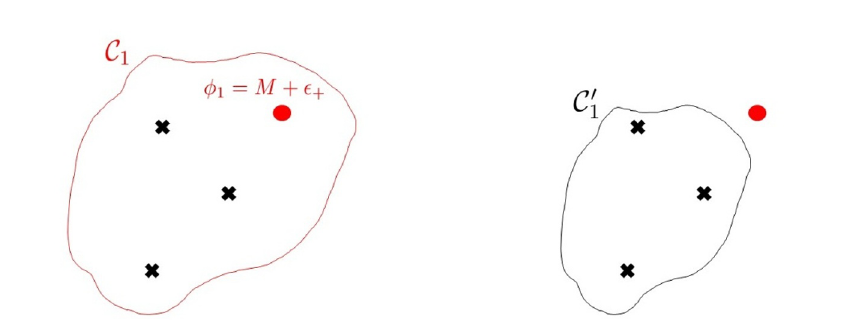
, from the pure partition function, while k . Such a pole is due to the factor Z ( k ) in the defect k , but with a modified integrand; for the contour 1